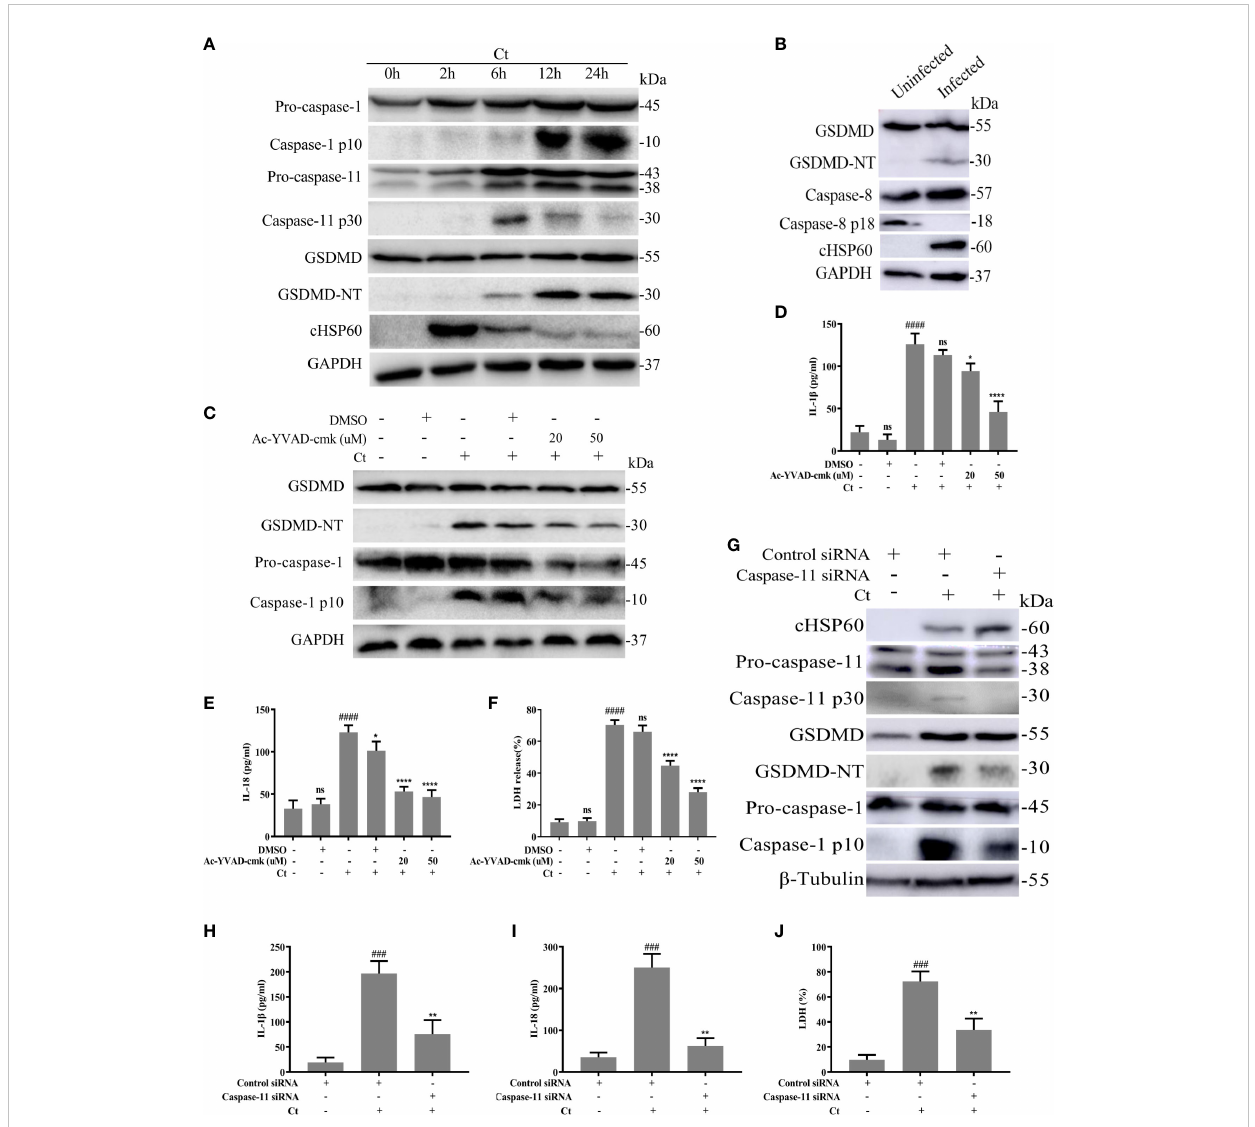
FIGURE 2 Chlamydia-induced GSDMD activation is accompanied by activation of Caspase-1 and caspase-11. (A) Immunoblot analysis showed expression of caspase-1, caspase-11, GSDMD and cHSP60 in RAW264.7 cells with C . trachomatis infection (MOI=5) at different time points. (B) Immunoblot analysis showed expression of GSDMD, caspase-8 and cHSP60 in RAW264.7 cells with C . trachomatis infection (MOI=5) at 12 hours post infection. For (C – F) , RAW264.7 cells were pretreated with Ac-YVAD-cmk for 30 minutes, then infected with C . trachomatis (MOI=5) for 12 hours. The same concentration of Ac-YVAD-cmk was maintained throughout the rest of the infection. (C) . Immunoblot analysis showed expression of GSDMD and caspase-1 in cell extract in RAW264.7 cells. For (G – J) , RAW264.7 cells were transfected with negative control siRNA or caspase-11 siRNA for 48 hours, then infected with C . trachomatis (MOI=5) for 12 hours. (G) . Immunoblot analysis showed expression of cHSP60, caspase-11, GSDMD and caspase-1 in cell extract in RAW264.7 cells. (D, E, H, I) . ELISA analysis showed IL-1 b and IL-18 secretion in culture supernatant in RAW264.7 cells. (F, J) . LDH release in supernatant was measured to estimate cell